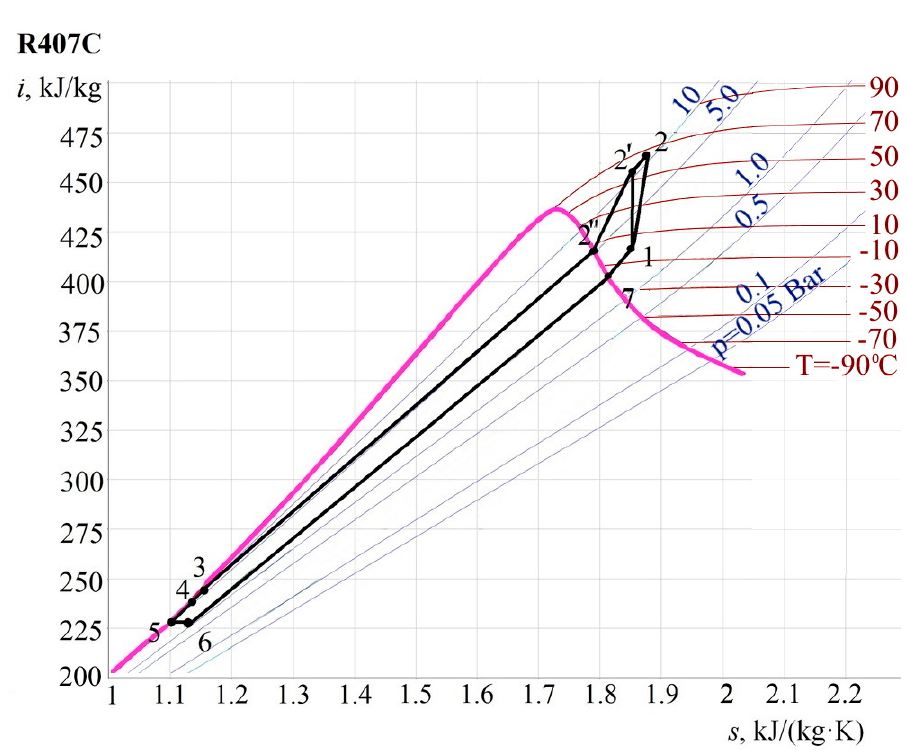
Figure 7. Heat pump plant cycle in i-s coordinates. Table 3. Specific values of the heat pump installation.